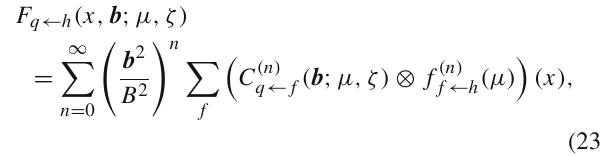
Fig. 2 Schematic picture of the regions in b -space of the TMDPDF and the corresponding/needed theoretical